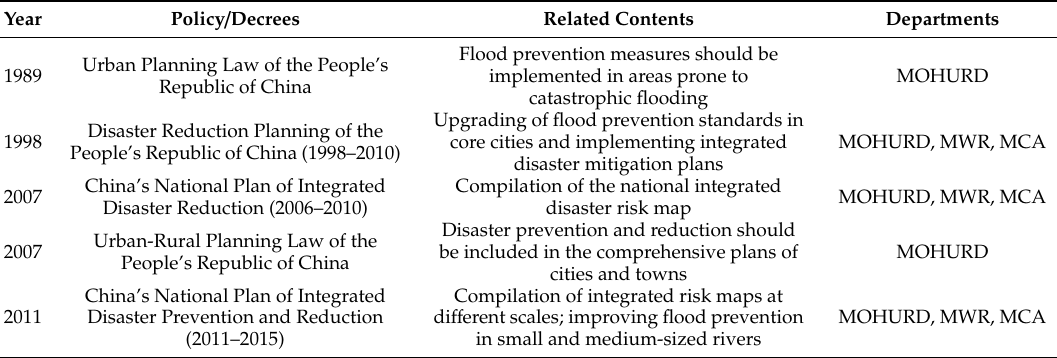
Table 8. Policies and decrees related to BLF in China from the 1980s to